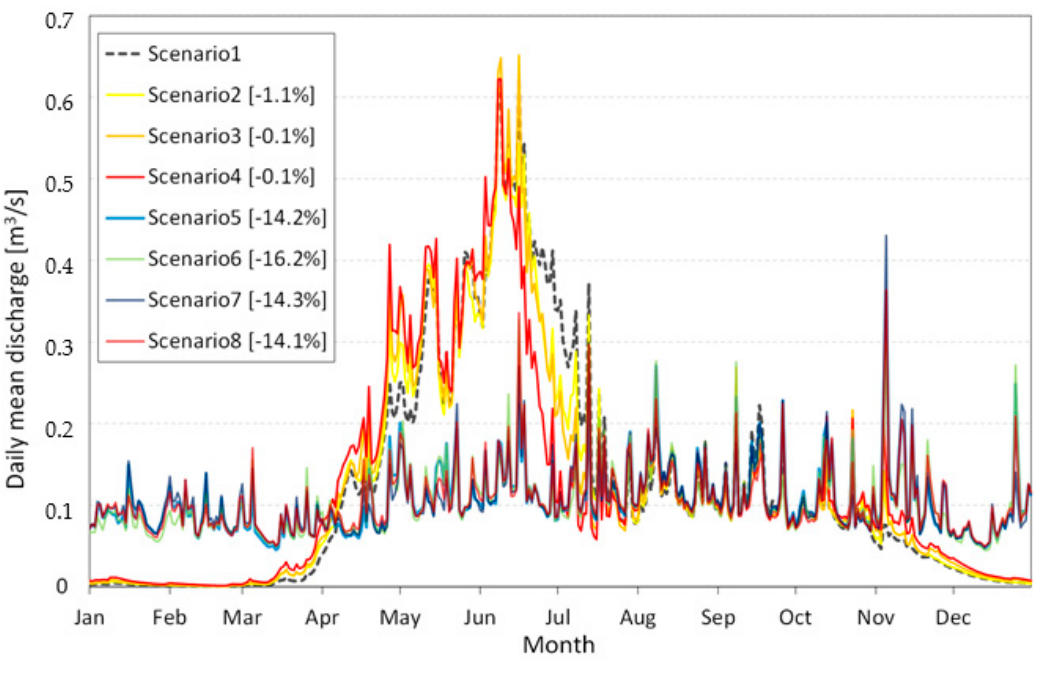
Figure 4. Daily discharge in Tremorgio reservoir for all climate scenarios modelled in 2030. They represent average values obtained from a 95% confidence interval. The mean annual volume variation relative to scenario 1 is shown for all scenarios.